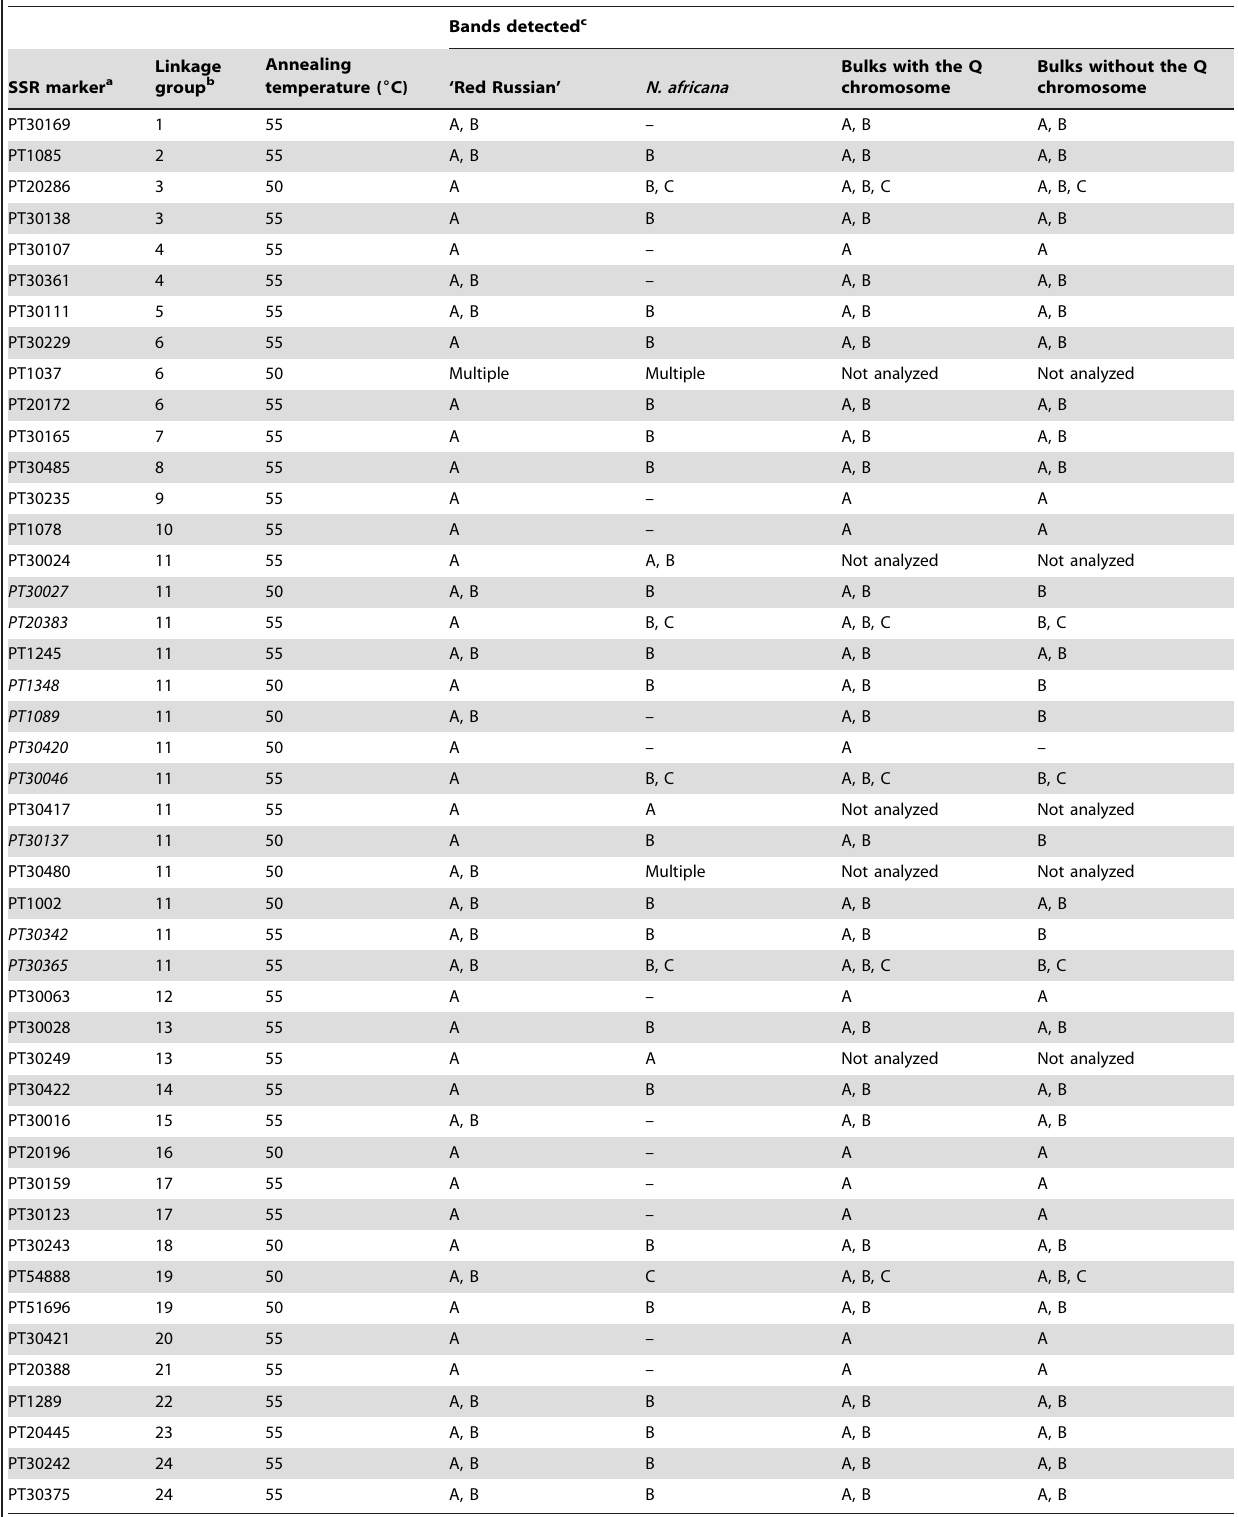
Bands detected c